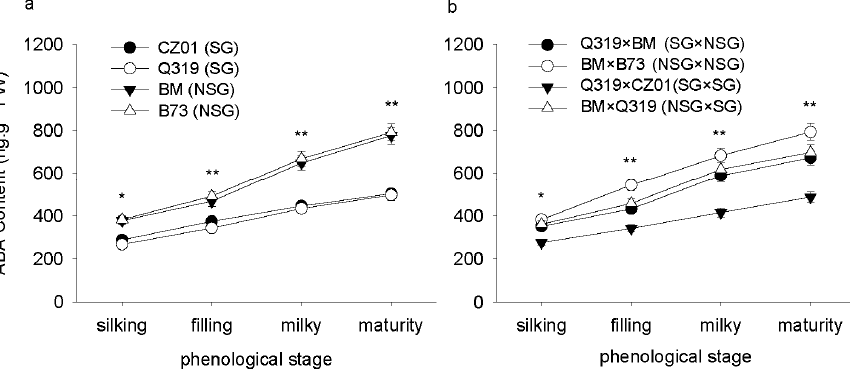
Figure 6. Abscisic acid (ABA) content in ear leaves from different maize genetic backgrounds after silking. Values are means ± standard deviation ( n = 3). * indicates a significant difference between treatments at p < 0.05. ** indicates a significant difference between treatments at p < 0.01. ( a ) represents inbred lines, ( b ) represents hybrids. SG1 and SG2 are two types of maize for a higher stay-green ratio; CZ01, Q319, BM, B73 are the names of maize varieties.